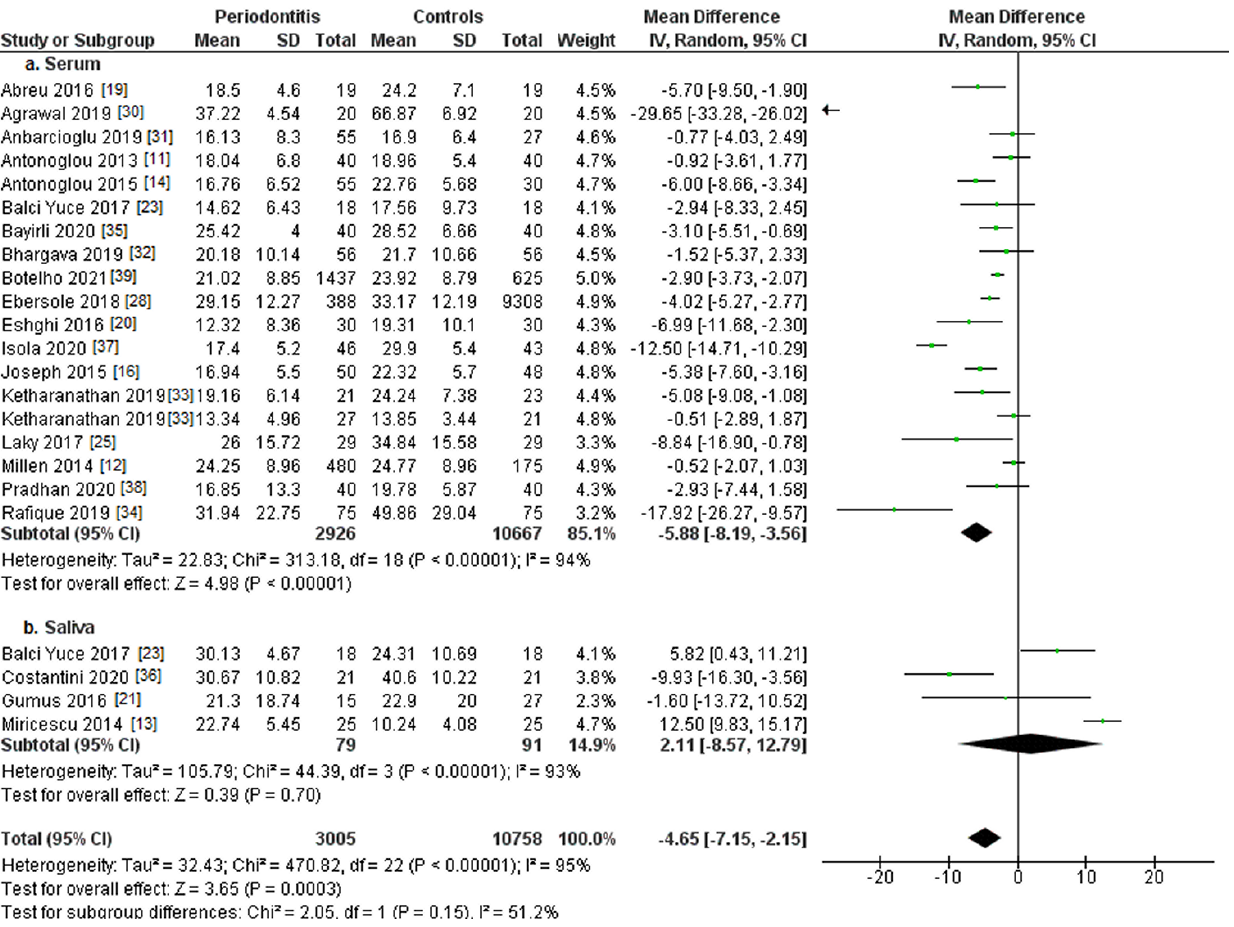
Figure 2: Study data and forest plot graph for serum (a) and salivary (b) vitamin D levels (ng/mL) in periodontitis patients and controls. Mean±SD: mean±standard